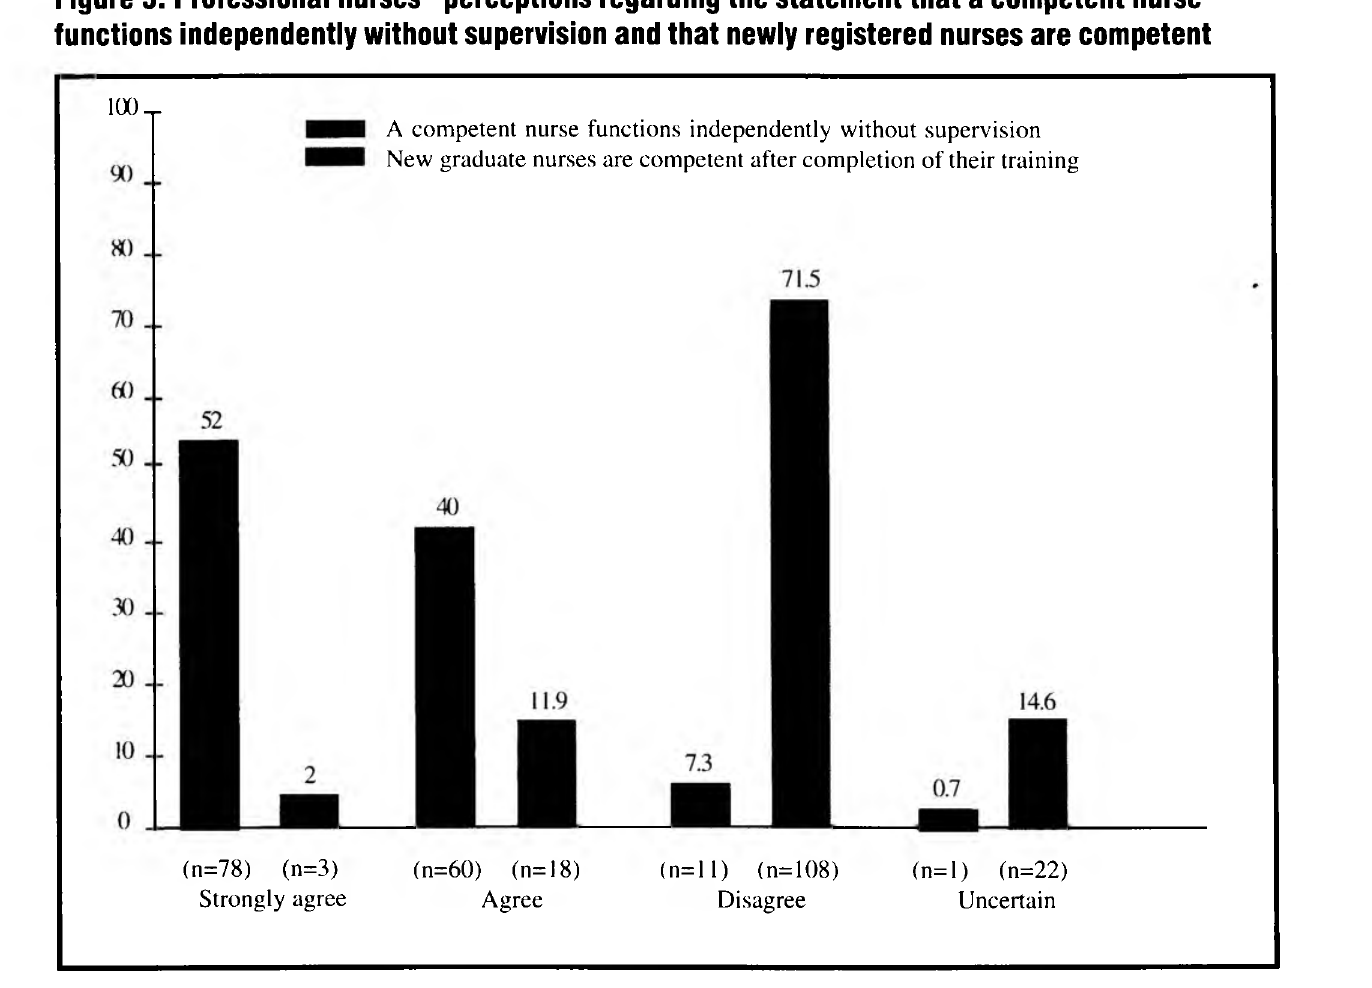
Figure 5: Professional nurses‘ perceptions regarding the statement that a competent nurse functions independently without supervision and that newly registered nurses are competent 100 ^ A competent nurse functions independently without supervision New graduate nurses are competent after completion of their training